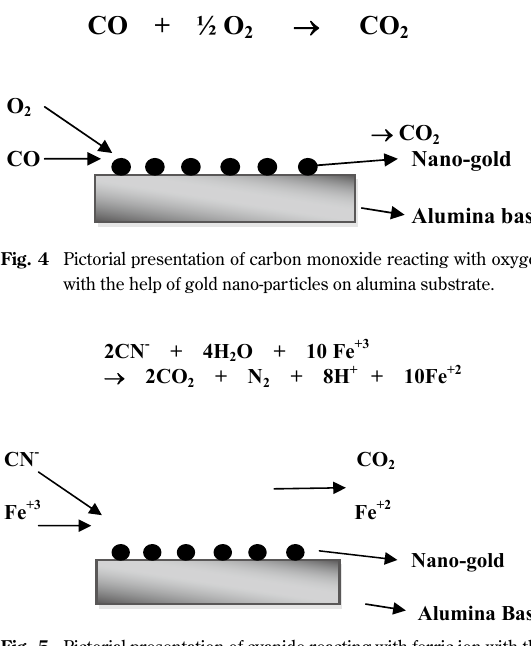
Pictorial presentation of cyanide reacting with ferric ion with the Fig. help of gold nano-particles.